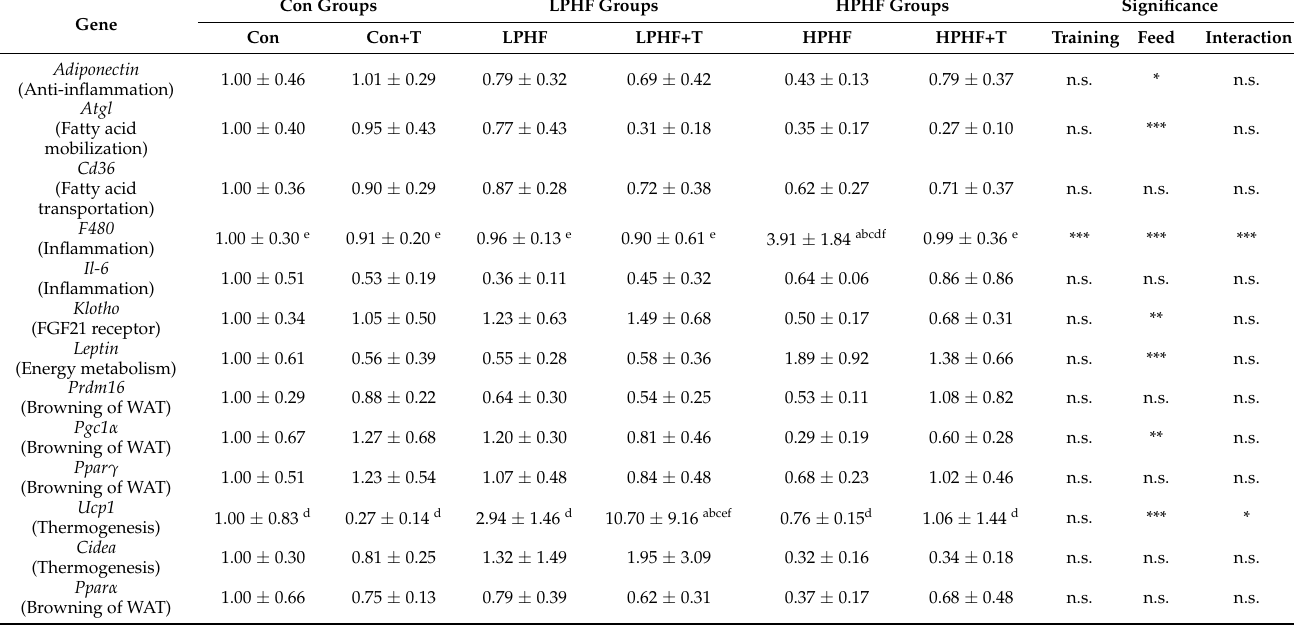
Table 5. Effects of LPHF, HPHF, and/or training on WAT gene